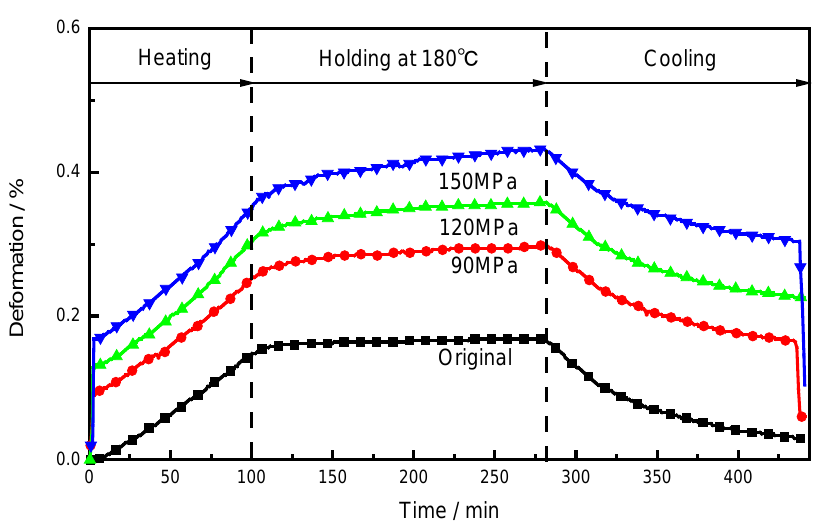
Figure 10. The deformation curves of the AA2024 aluminum alloy during non-isothermal loading.